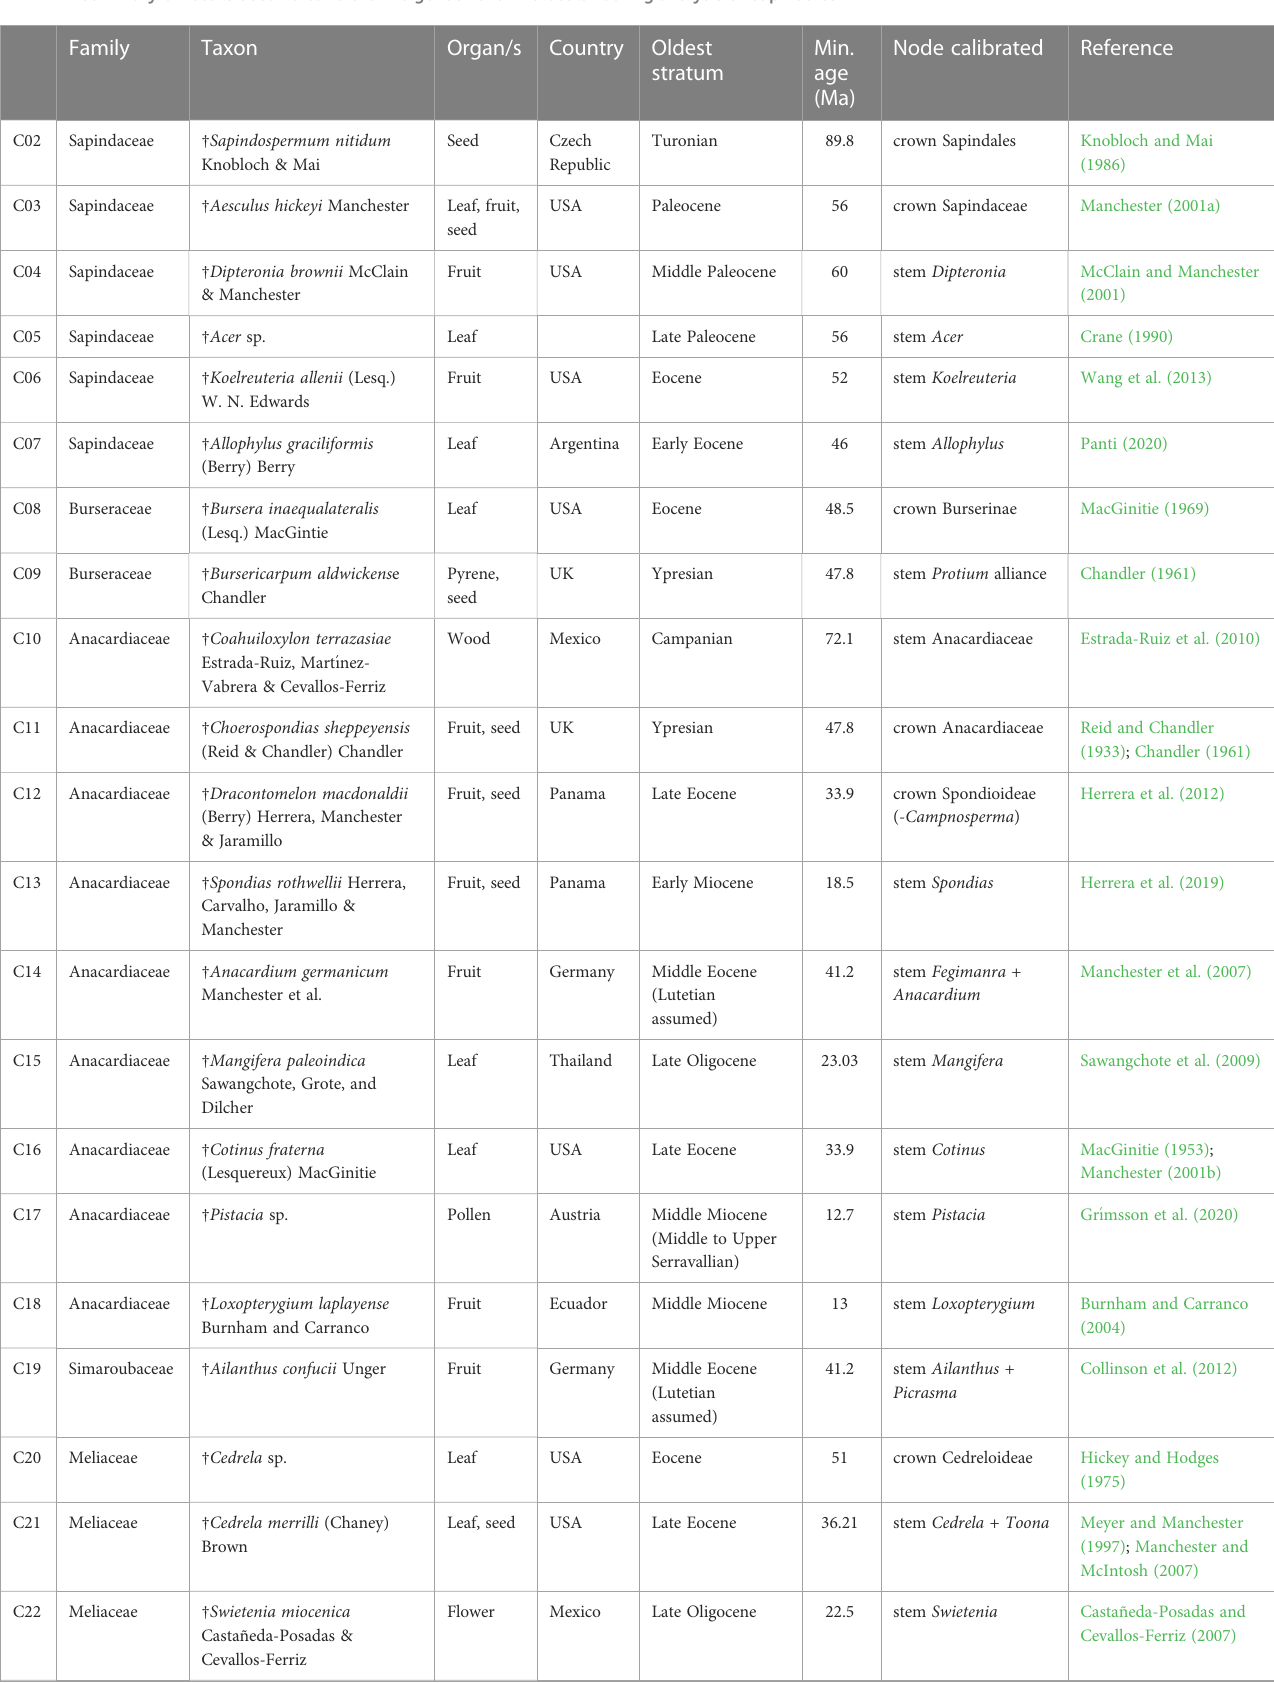
TABLE 1 Summary of fossils used to calibrate the genus-level molecular dating analysis of Sapindales.